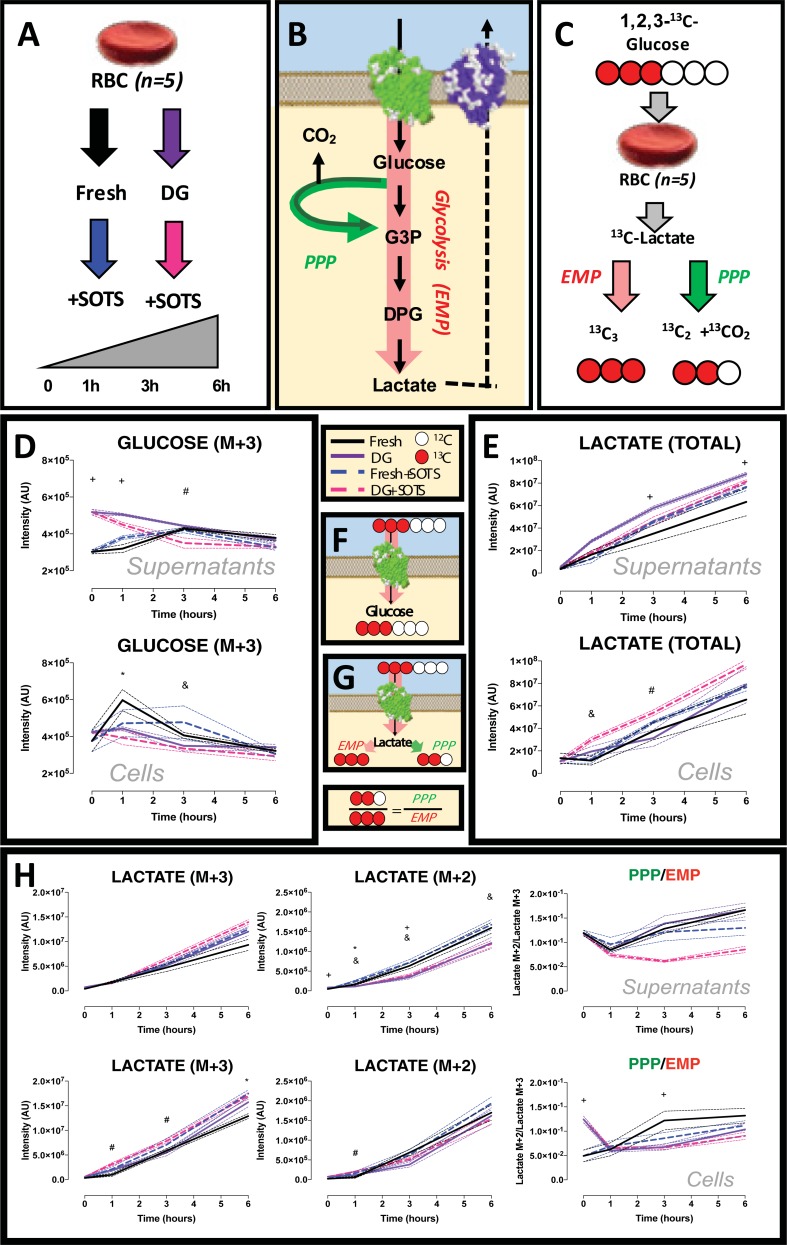
Comparison of metabolomic steady state phenotypes and metabolic fluxes in response to oxidant stress in fresh and matched deglycerolized RBCs.(A) Tracing experiments were performed by incubating RBCs with [1,2,3-13C3]glucose, a heavy substrate that can be metabolized in RBCs through (B) the Embden-Meyerhof-Parnas (EMP) glycolytic pathway (generating isotopologue M+3) or through the pentose phosphate pathway (PPP), generating isotopologue M+2 of lactate, (C) owing to the release of the first carbon atom of heavy glucose in the form of 13CO2 at the oxidative phase reactions of the PPP. (F) Schematic overview of glucose uptake and consumption in RBC supernatants and cells, in fresh, or deglycerolized RBCs, either untreated, or treated with the superoxide generator (SOTS-1), (D) demonstrating in both RBCs and media similar glucose consumption rates. (E) Total lactate, i.e., sum of lactate isotopologues (unlabeled M+0, M+3 generated via glycolysis, or M+2 generated via the PPP), in fresh and DG RBCs, either untreated or treated with the superoxide generator (SOTS-1), demonstrating in both RBCs and media similar lactate accumulation. (G and H) Schematic overview of expected isotopologues and relative ratios of lactate, from glycolysis (EMP, M+3 isotopologue) or PPP (M+2) and relative ratios in fresh and DG RBCs, either untreated, or treated with the supoxide generator SOTS-1. (H) Fresh RBCs were characterized by significantly higher levels of supernatant–but not intracellular—M+2 lactate. Conversely, deglycerolized RBCs were characterized by faster glycolysis than fresh RBCs. Lower lactate M+2 export in deglycerolized RBCs following SOTS-1 was observed, while intracellular glycolysis to pentose phosphate pathway ratios were comparable between fresh and deglycerolized RBCs following treatment with SOTS-1. Continuous lines indicate median, while dashed lighter lines are representative of interquartile ranges, according to the color legend left. Symbols indicate p<0.05 + = fresh vs DG; & = fresh + SOTS vs DG + SOTS; * = fresh vs fresh + SOTS; # = DG vs DG + SOTS.